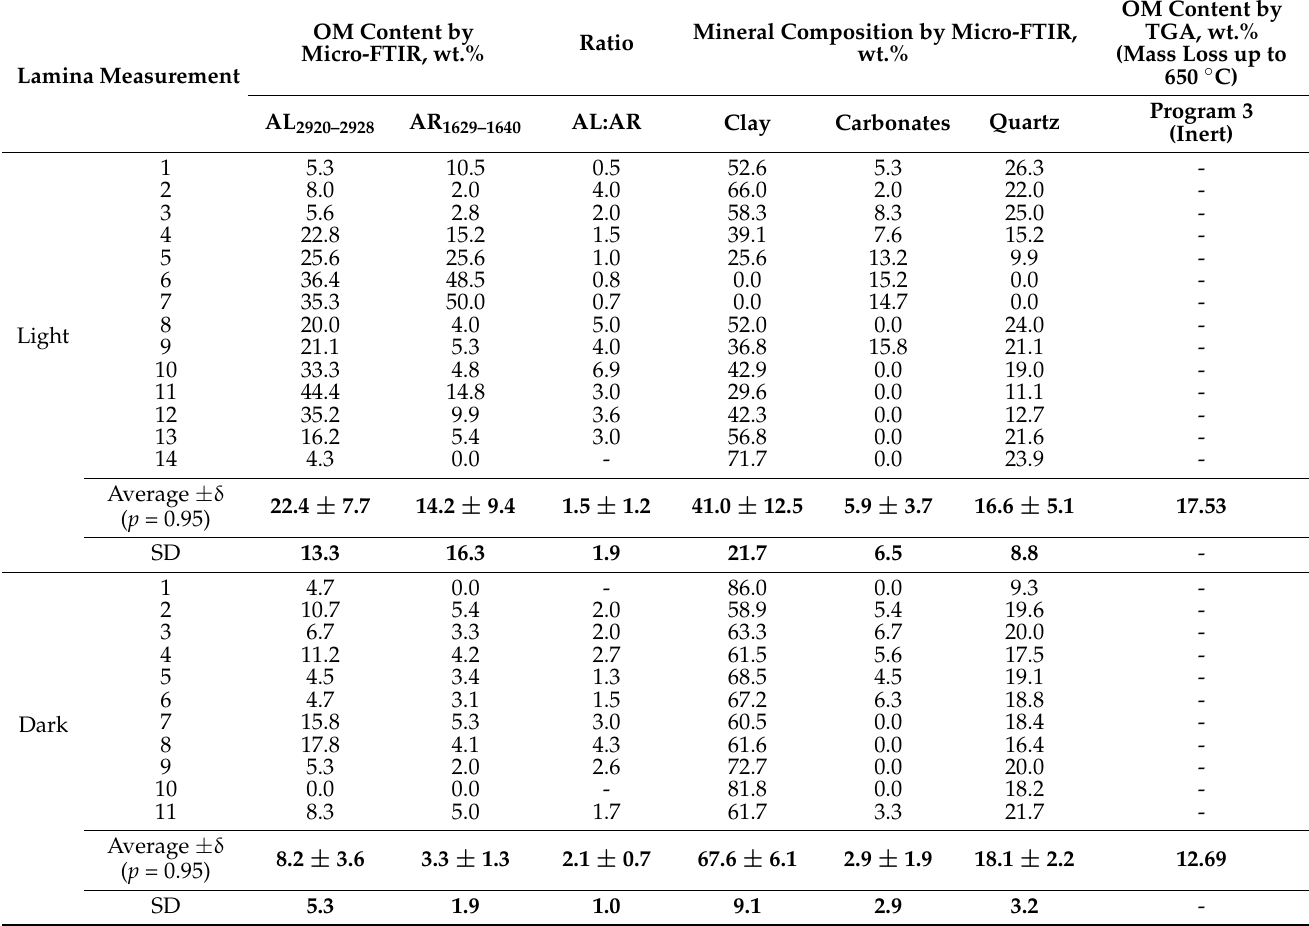
Table 5. The evaluation of organic matter (OM) content and composition (aliphatic/aromatic ratio) and mineral content in the Bazhenov rock sample by FTIR microscopy.